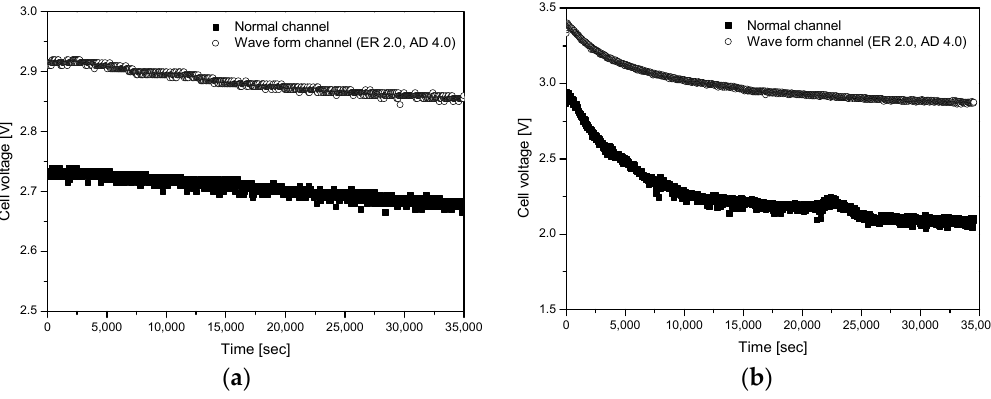
Figure 15. Performance curve of the normal channel and wave form channel operated for 10 h, at a current density (CD) of ( a ) 0.8 and ( b ) 1.0.